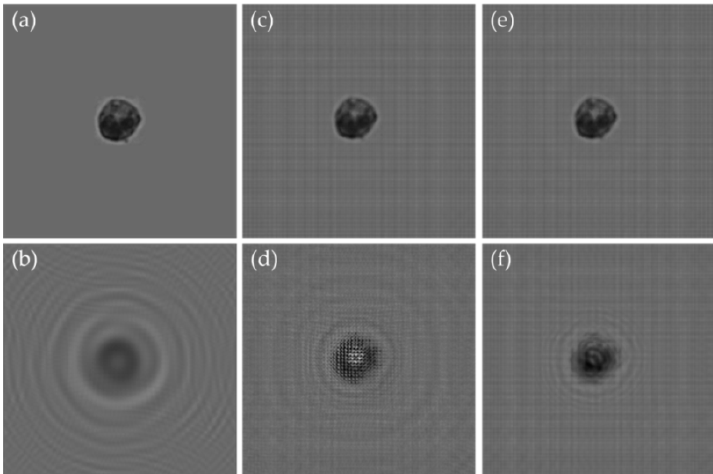
Figure 5. The result of our proposed method and classic method without a phase constraint. ( a ) The image captured by a 20× object lens microscope; ( b ) the diffractive image on the image plane; ( c ) the image reconstructed by Gabriel Koren’s method with 0% deviation in distance; ( d ) the image reconstructed by Gabriel Koren’s method with 20% deviation in distance; ( e ) the image reconstructed by our modified method with 0% deviation in distance; ( f ) the image reconstructed by our modified method with 20% deviation in distance.